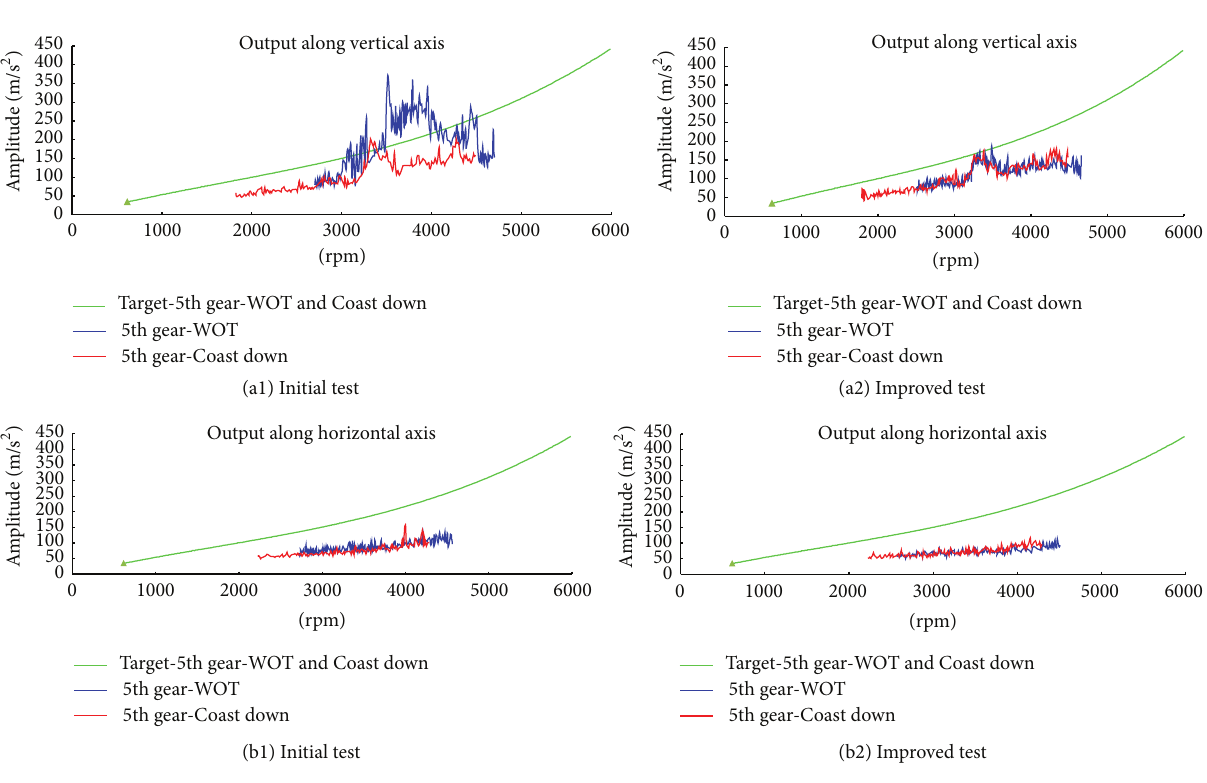
Figure 10: Test curves along vertical and horizontal axis.